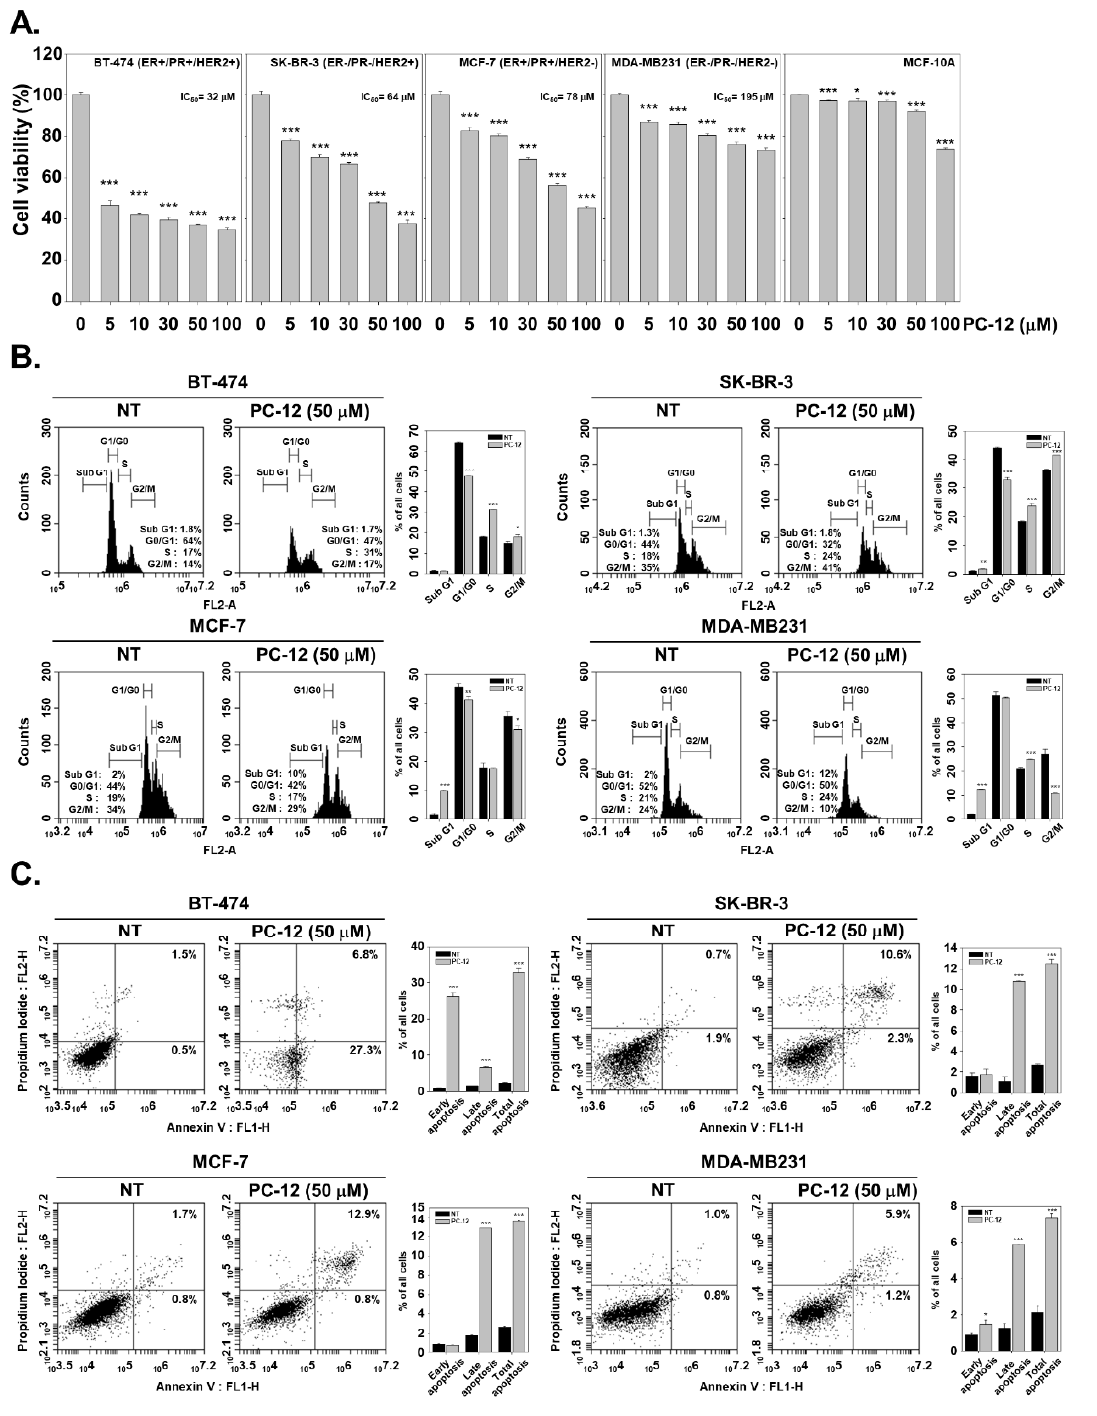
Figure 2. PC-12 produced loss of cell viability and induced cell cycle arrest. ( A ) MTT assay was performed for cell viability in PC-12-treated breast cell lines. BT-474, SK-BR-3, MCF-7, MDA-MB-231, and MCF-10A cells were treated with PC-12 (0–5–10–30–50–100 µM) for 24 h. *** p < 0.001 and * p < 0.05 vs. non-treated (NT) group. ( B ) Cells were exposed to PC-12 (0–50 µM) for 24 h, and cell cycle analysis was performed. *** p < 0.001, ** p < 0.01, and * p < 0.05 vs. non-treated (NT) group. ( C ) The four breast cancer cell lines were treated with 0–50 µ M of PC-12 for 24 h, and cells were collected. The apoptotic cells were detected by flow cytometry using an Annexin/PI staining assay. *** p < 0.001 and * p < 0.05 vs. non-treated (NT)